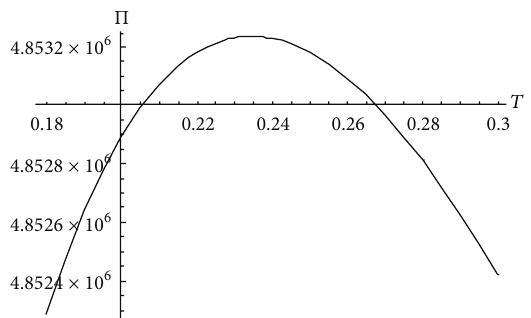
Figure 2: Graphic illustrations of Π versus 𝑇